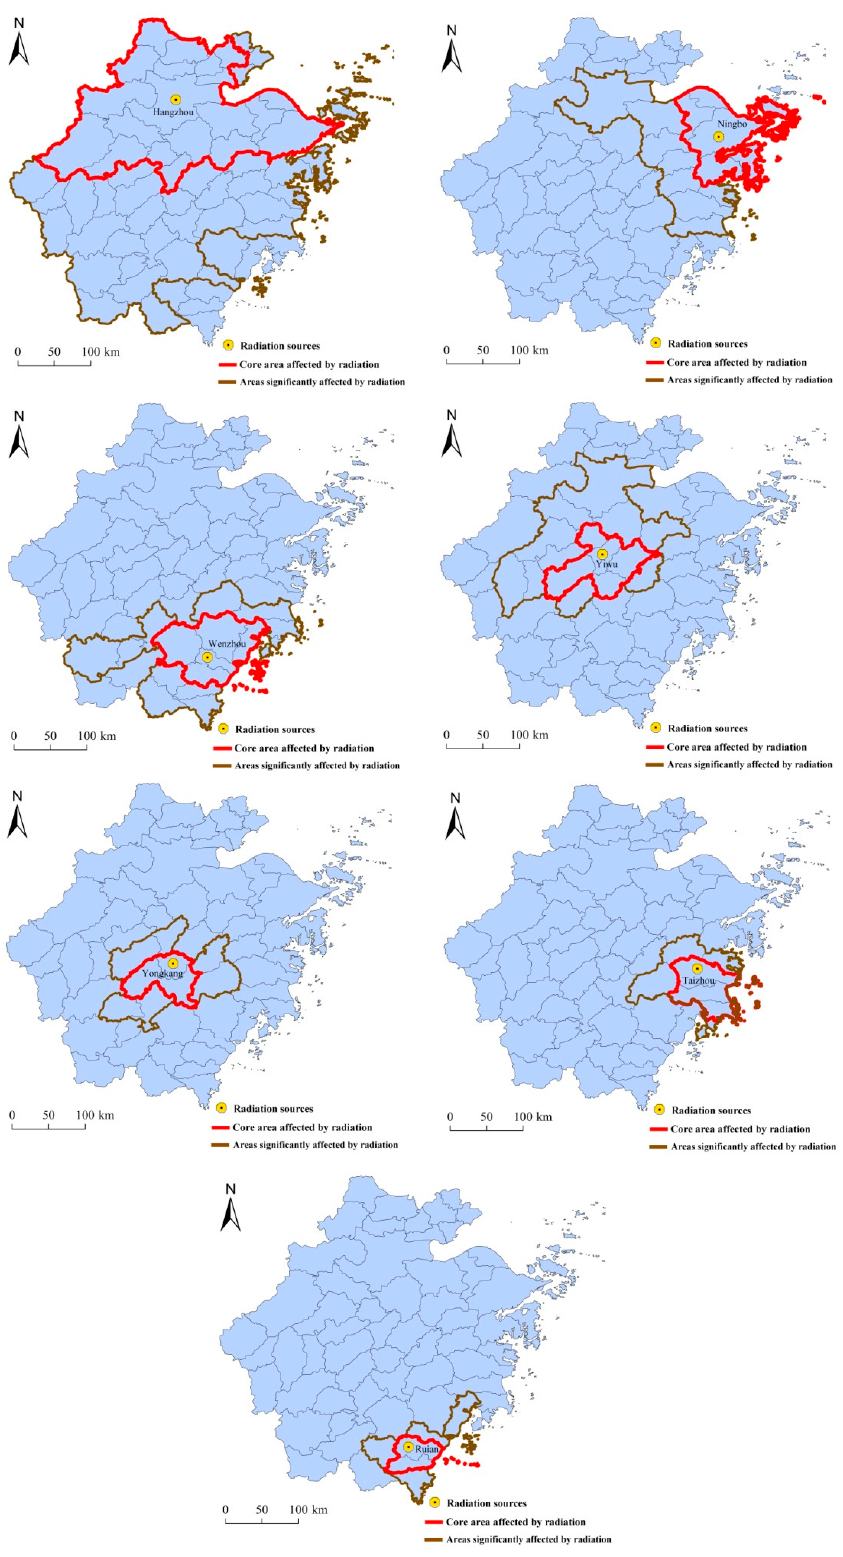
Figure 4. The spatial range of e-retail economic links at county level in Zhejiang Province.